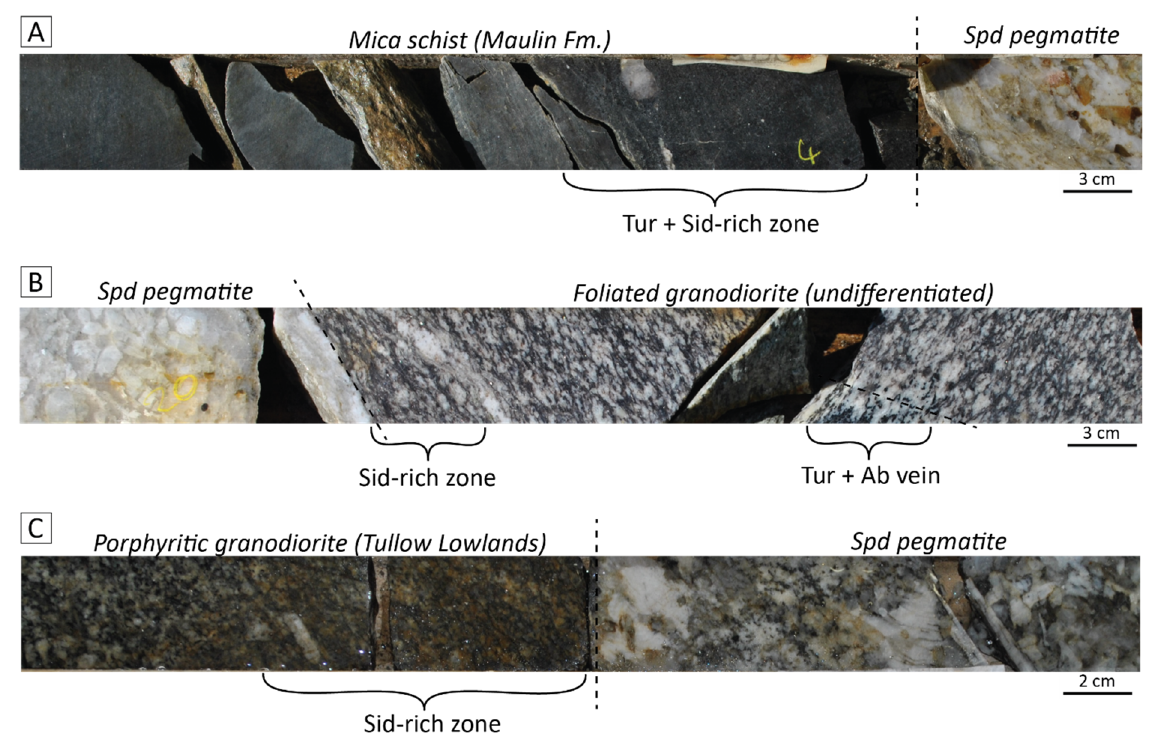
Figure 4. Exocontacts of spodumene pegmatites in the three country rock types. Mineral abbreviations: Ab = albite, Sid = siderophyllite, Spd: spodumene, Tur = tourmaline. ( A ) Hanging wall mica schist with a 15 cm zone of tourmaline and siderophyllite enrichment just above the spodumene pegmatite top contact, drill hole ACL 13-02. ( B ) Footwall foliated granodiorite with 5 cm zone enriched in siderophyllite adjacent to spodumene pegmatite bottom contact; note tourmaline-rich vein further from the contact, drill hole ACL 13-02. ( C ) Hanging wall porphyritic granodiorite with 10 cm zone enriched in siderophyllite just above spodumene pegmatite top contact, drill hole MOY 13-03.